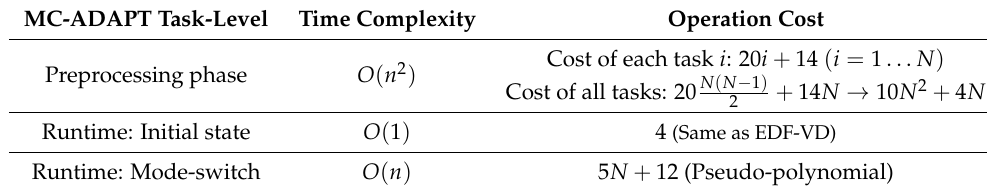
Table 4. Time and space complexity of Algorithm 2.